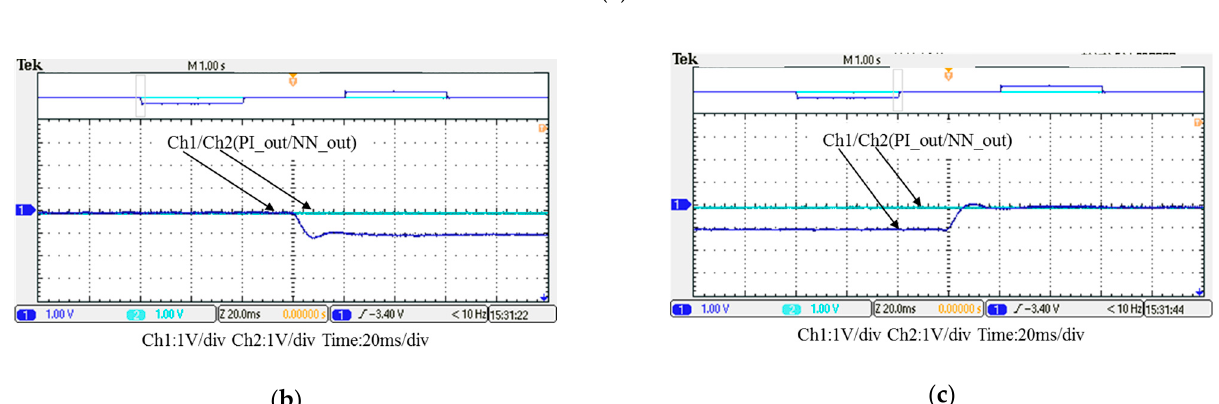
Figure 29. Case 1 implementation result: reactive power controller outputs: ( a ) full view; ( b ) detailed view near t 1 ; ( c ) detailed view near t 2 (all control signals are in V).